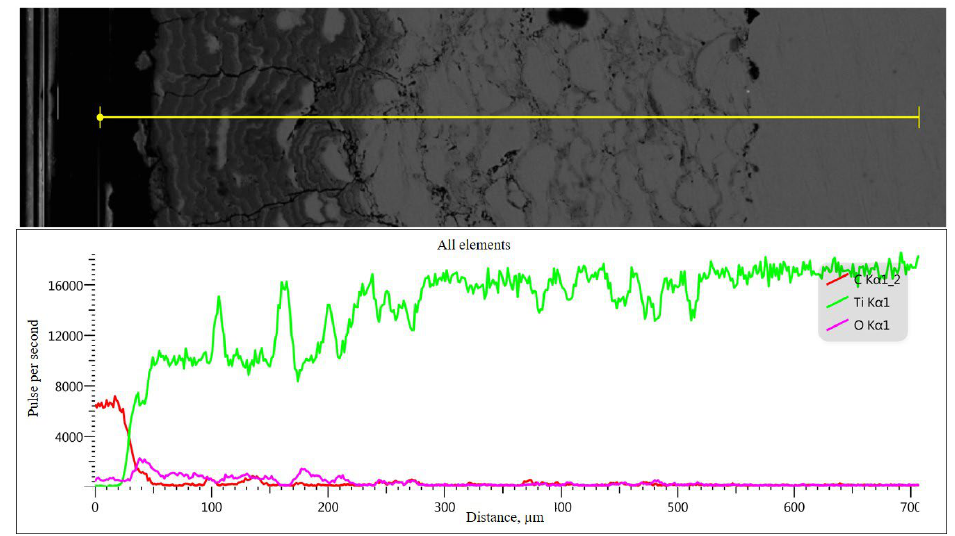
Figure 8. EDS analysis along the cross-sectional line of the coating that has a gradient structure.